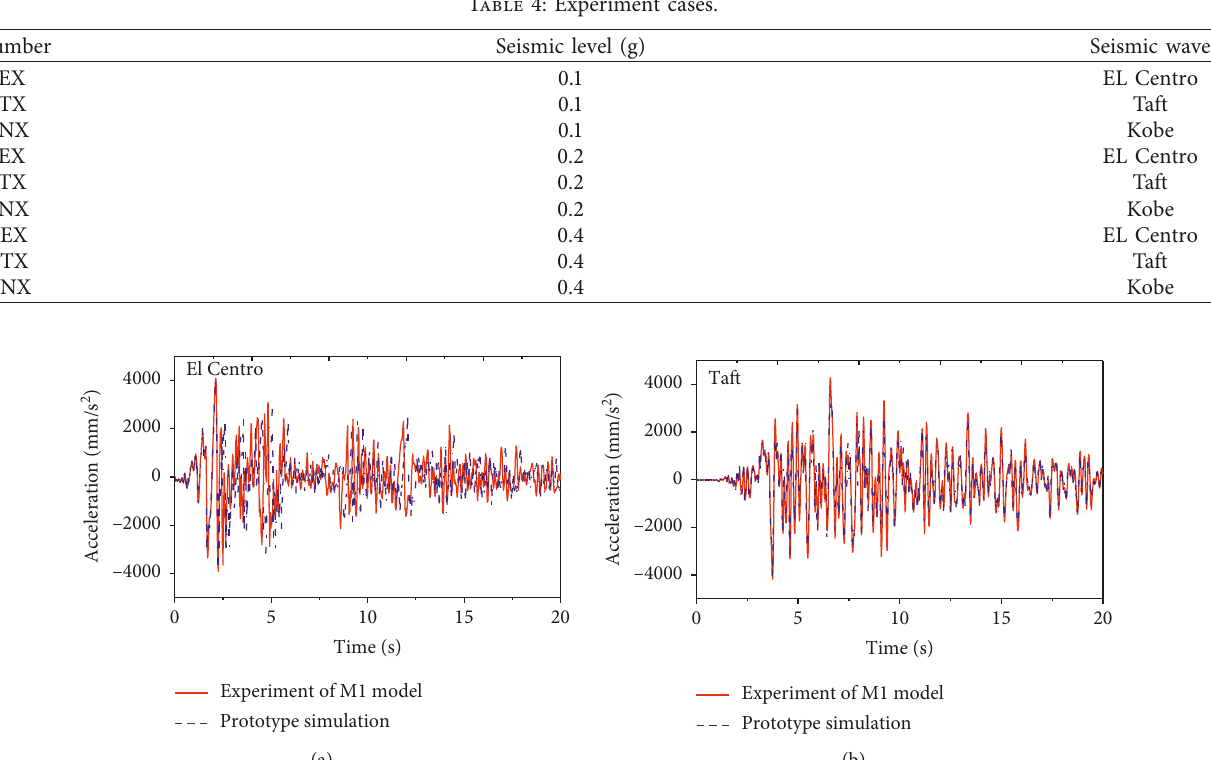
Table 4: Experiment cases.